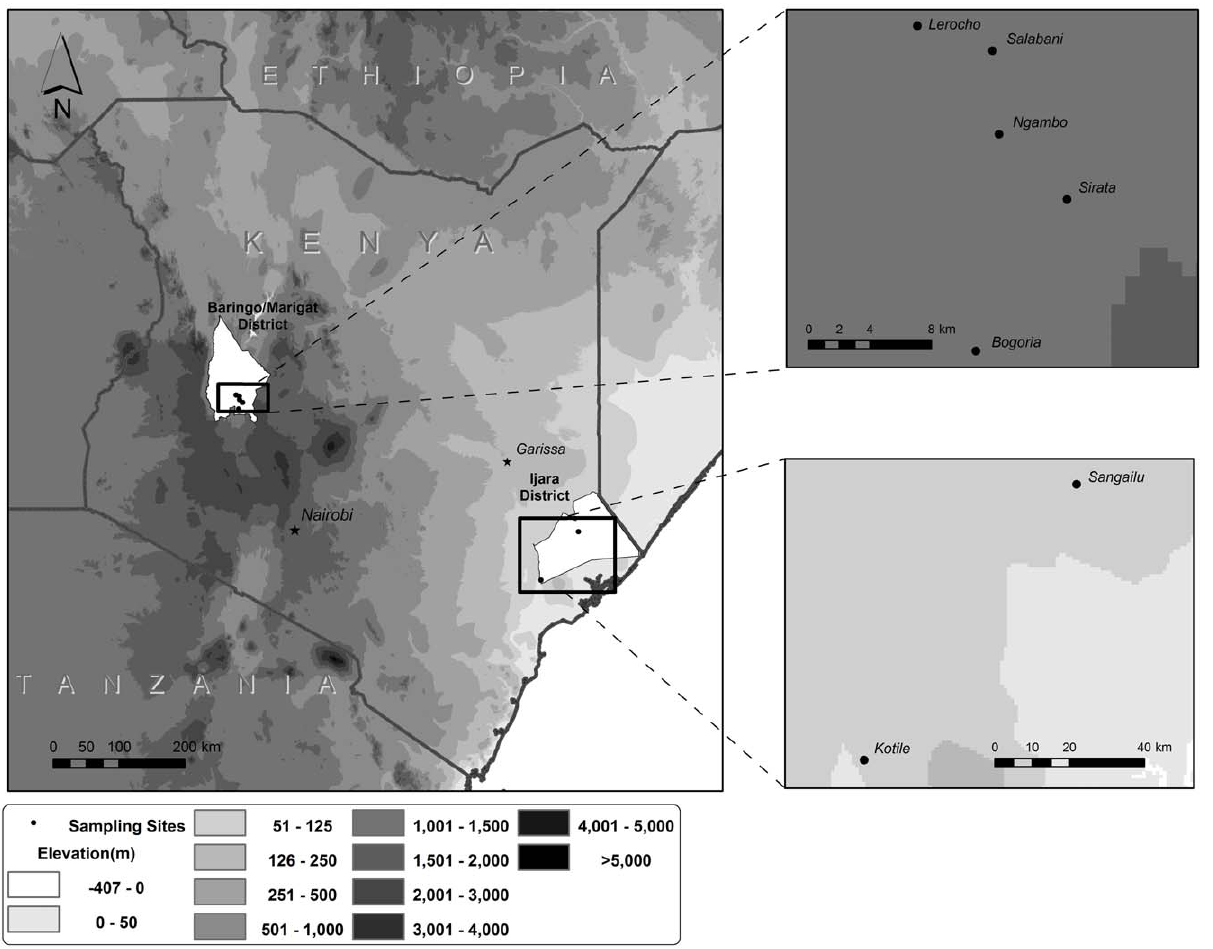
Figure 1. Map of Kenya showing the location of the study sites.